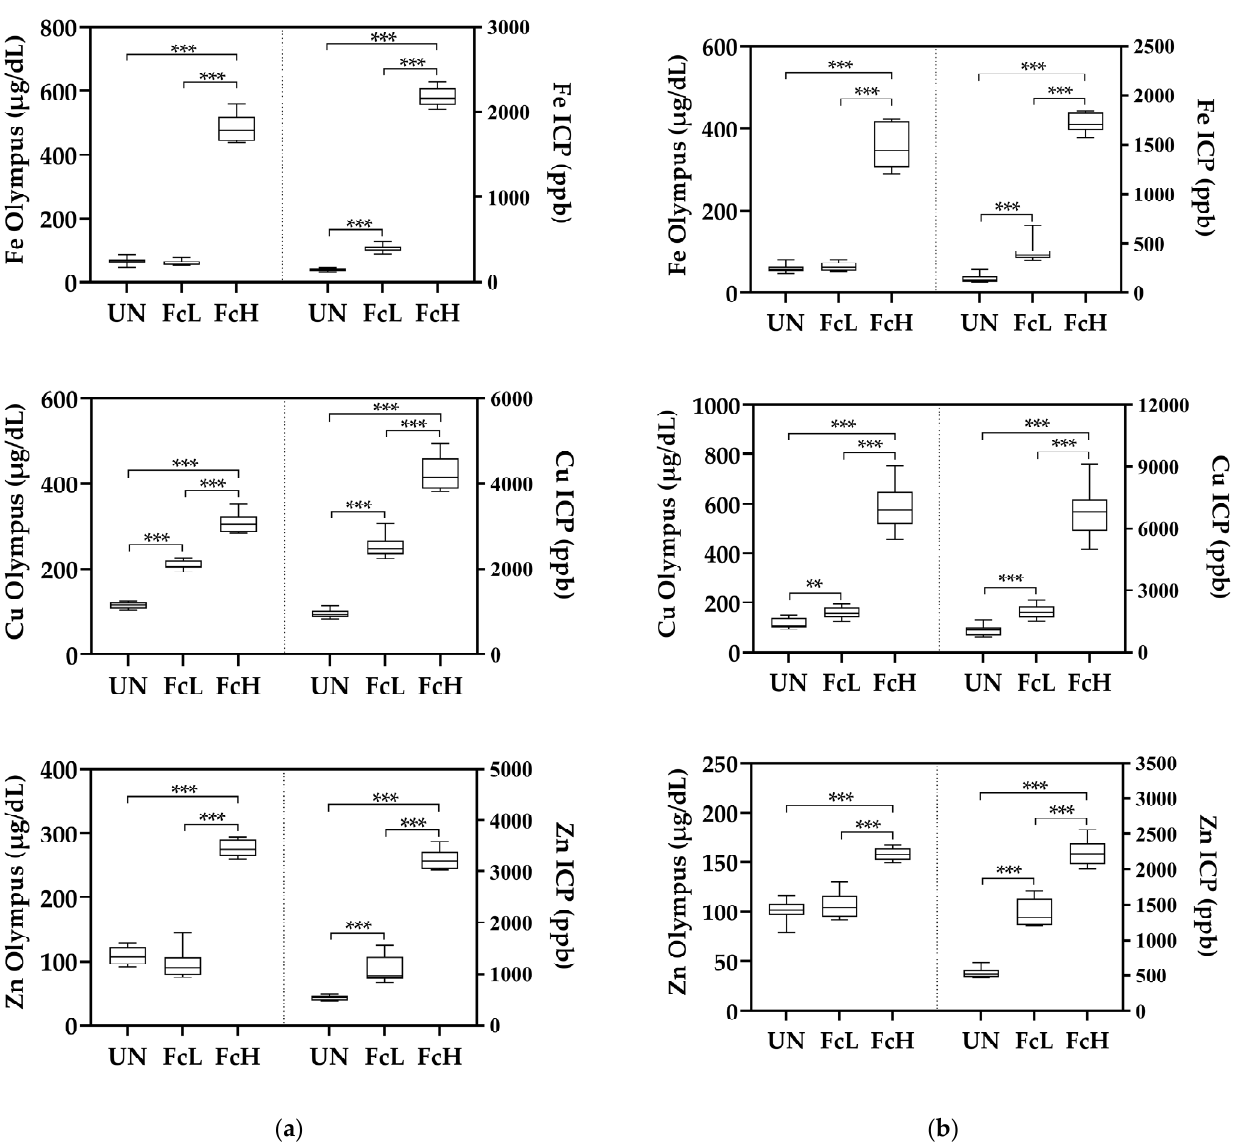
Figure 2. Results for the zinc (Zn), copper (Cu) and iron (Fe) after adding different quantities of pen feces ( a ) or feed ( b ) in pig saliva. Concentrations obtained in saliva pools without any treatment (UN—untreated)), after adding low quantity of pen feces or feed (FcL) and high quantity of pen feces or feed (FcH) by automated colorimetric assays and by ICP-MS method. p B : p value of the Bonferroni post hoc analysis. Asterisks indicate significant differences from the C group (***: p < 0.001).